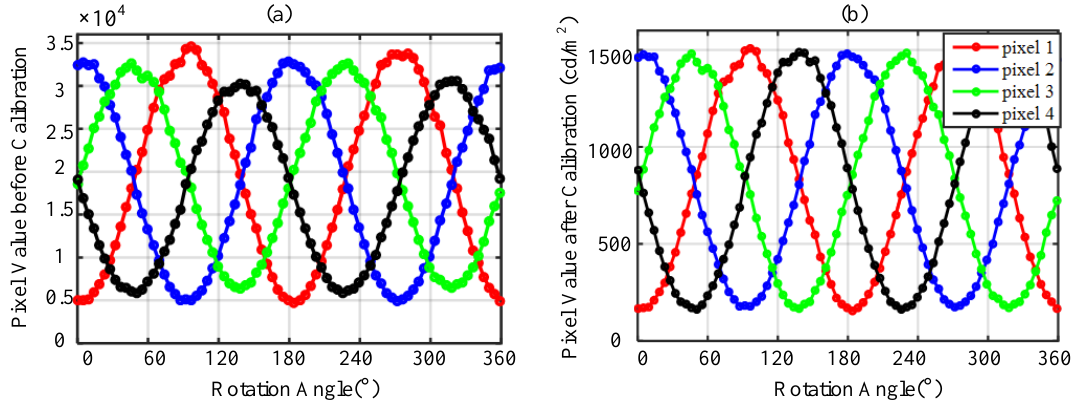
Figure 6. The values of four pixels in a polarization measurement unit fluctuate with the rotation of the turntable. ( a ) response curves before calibration; ( b ) response curves after calibration. Powell et al. [37] proposed another calibration formulation for pixelated polarized light